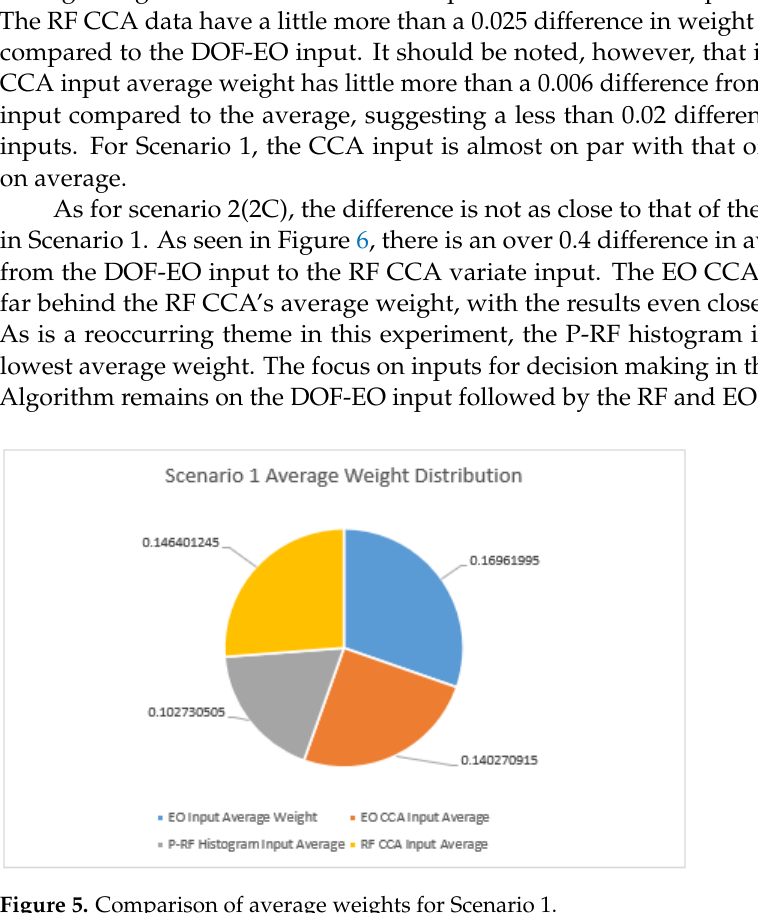
Figure 5. Comparison of average weights for Scenario